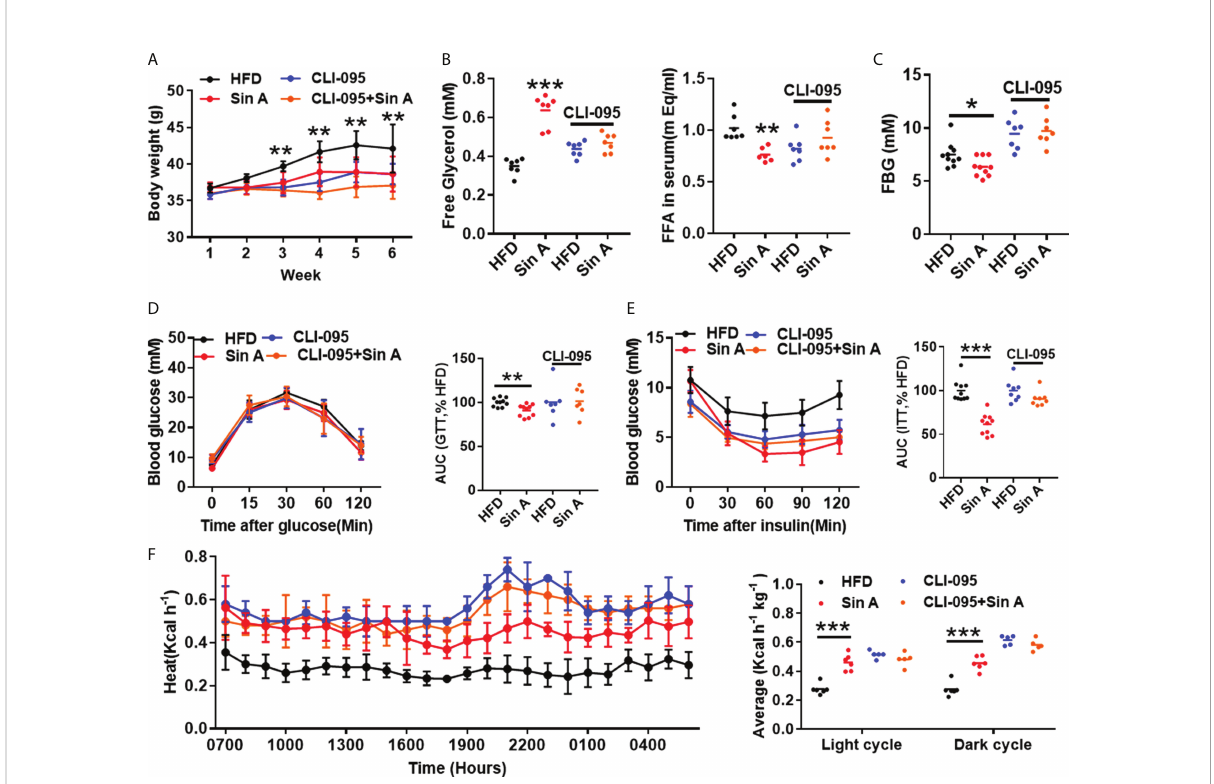
FIGURE 5 Sin A mediates LPS-TLR4 signaling to ameliorate HFD-induced obesity and insulin resistance in NAFLD mice. Vehicle-group mice were treated with vehicle (HFD) or Sin A (80 mg/kg); CLI-095 group mice were treated with vehicle (HFD) or Sin A (80 mg/kg). (A) Body weight evaluation of 6 weeks for HFD, Sin A, CLI-095 and CLI-095 + Sin A groups ( n =5 – 8 per group). (B) Serum free glycerol levels and free fatty acids (FFAs) ( n =5 – 7 per group). (C) Fasting blood glucose (FBG) levels ( n =7 – 10). Results of (D) glucose tolerance test (GTT) and (E) insulin tolerance test (ITT) ( n =7 – 8 per group). (F) Heat expenditure and its respective average of light cycle and dark cycle ( n =5 – 6 per group). Values represent mean ± SD. Signi fi cance was determined by two-way ANOVA for the multiple-group comparisons. p *<0.05; ** p <0.01; *** p <0.001. FFA, fatty fat acid; FBG, fasting blood glucose; GTT, glucose tolerance test; ITT, insulin tolerance